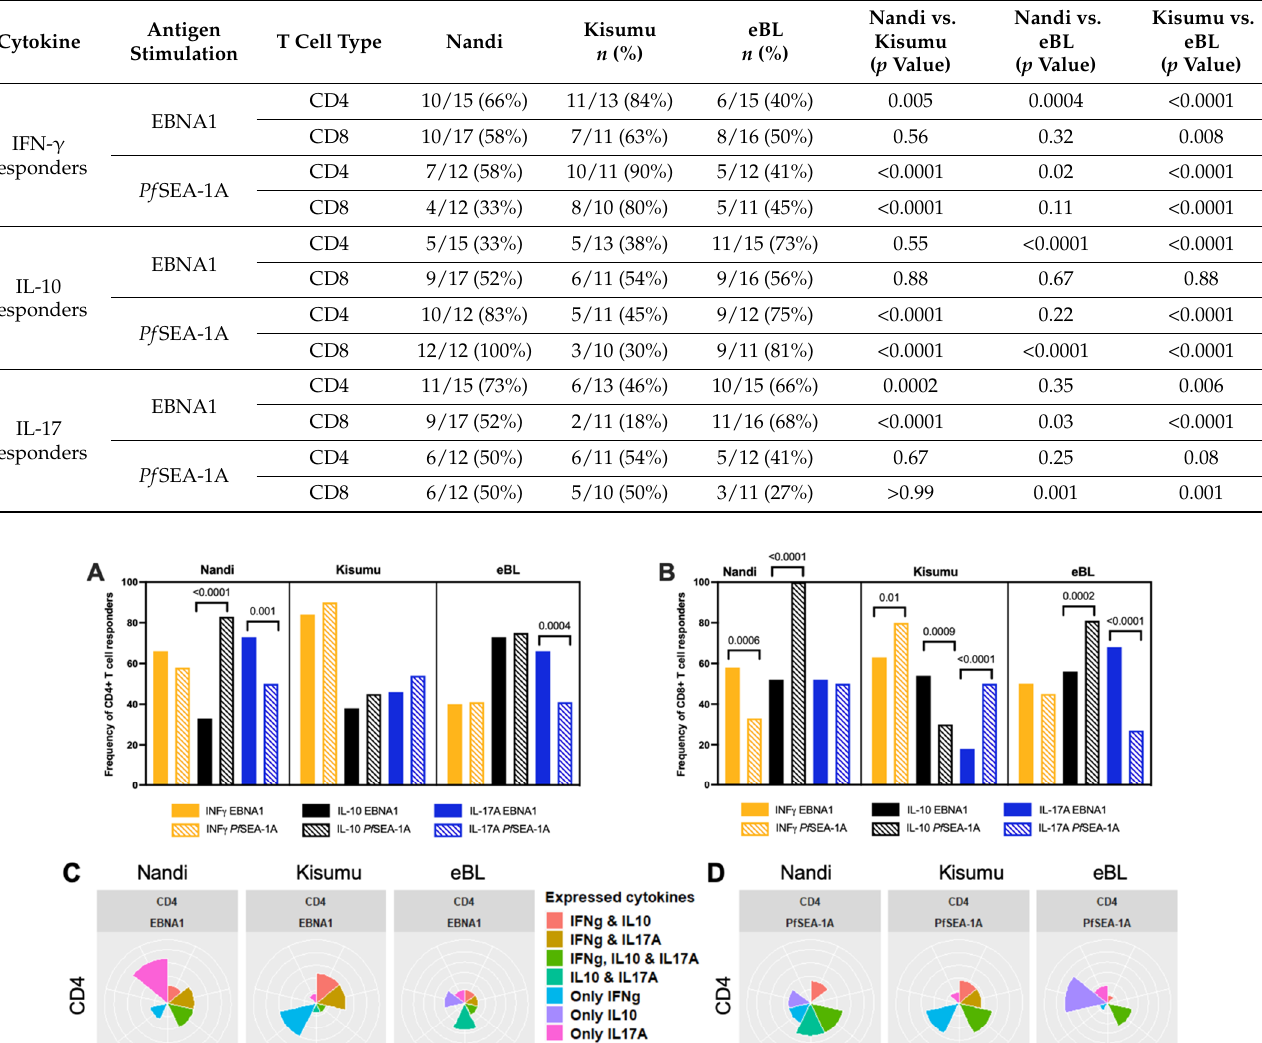
Table 1. The frequency of cytokine responders for EBNA1 and Pf SEA-1A across study groups. A responder was defined as a child whose T cells produced significantly higher levels of cytokine after ex vivo antigen stimulation compared to their unstimulated, DMSO control cells using chi-square statistics. The frequency of responders was reported for each study group: Nandi, Kisumu and eBL children, and then compared across groups for each cytokine (i.e., IFN- γ , IL-10 or IL-17A), antigen (EBNA1 or Pf SEA-1A) and type of T cell response (CD4 + and CD8 + ) by Fisher’s exact test; p -values < 0.05 were considered significant.